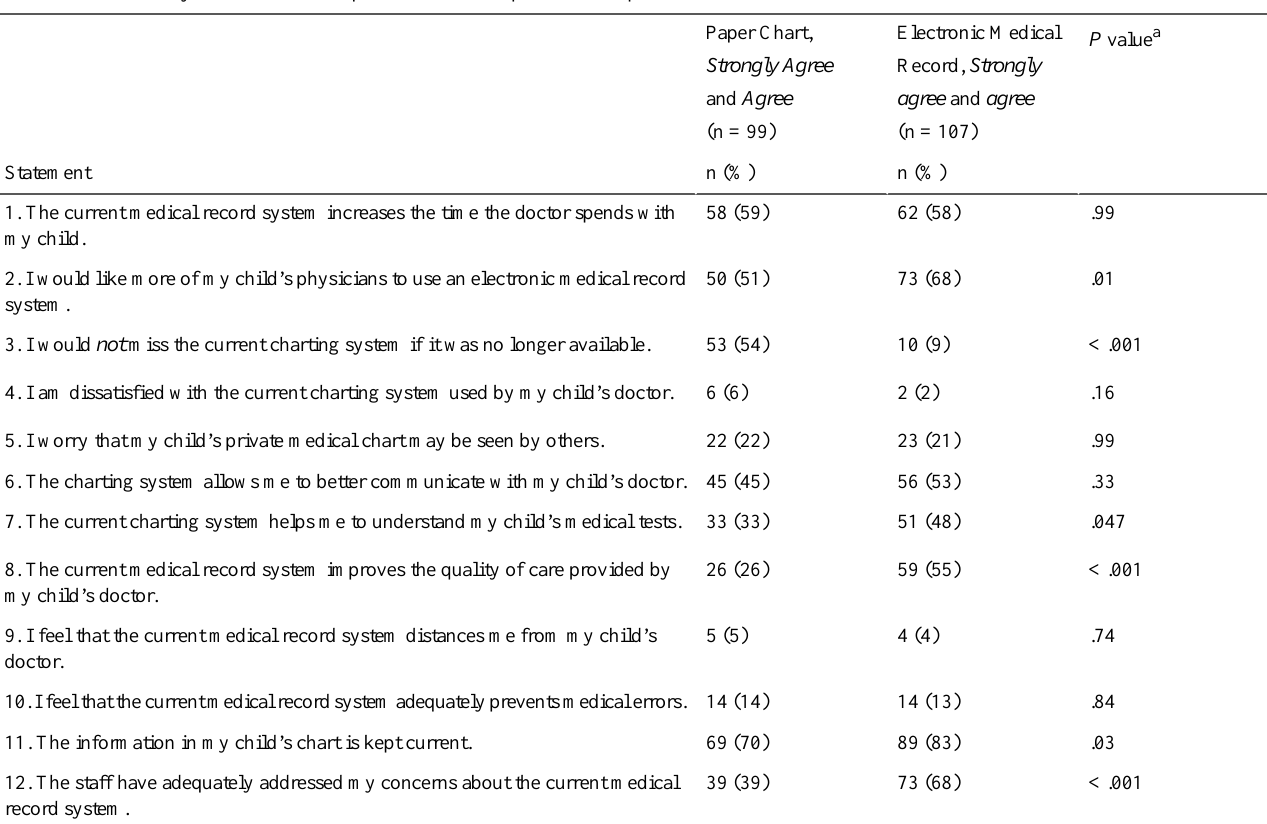
Table 2. Parent survey of medical record pre- and 3 months post-EMR